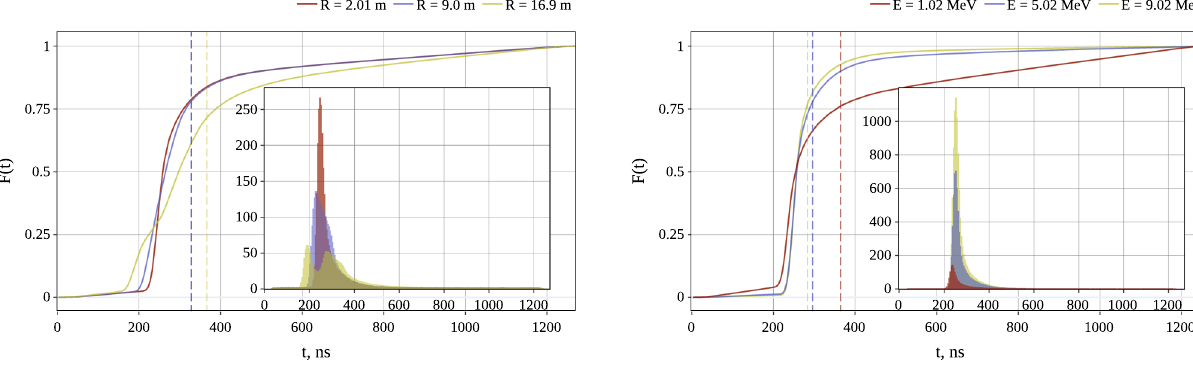
Fig. 5 Examples of CDFs and PDFs for FHT distributions for events with the kinetic energy of E kin = 1 MeV but different radius (left) and events at the center of the detector ( R = 0) but different energies (right). Dashed lines denote PDF mean